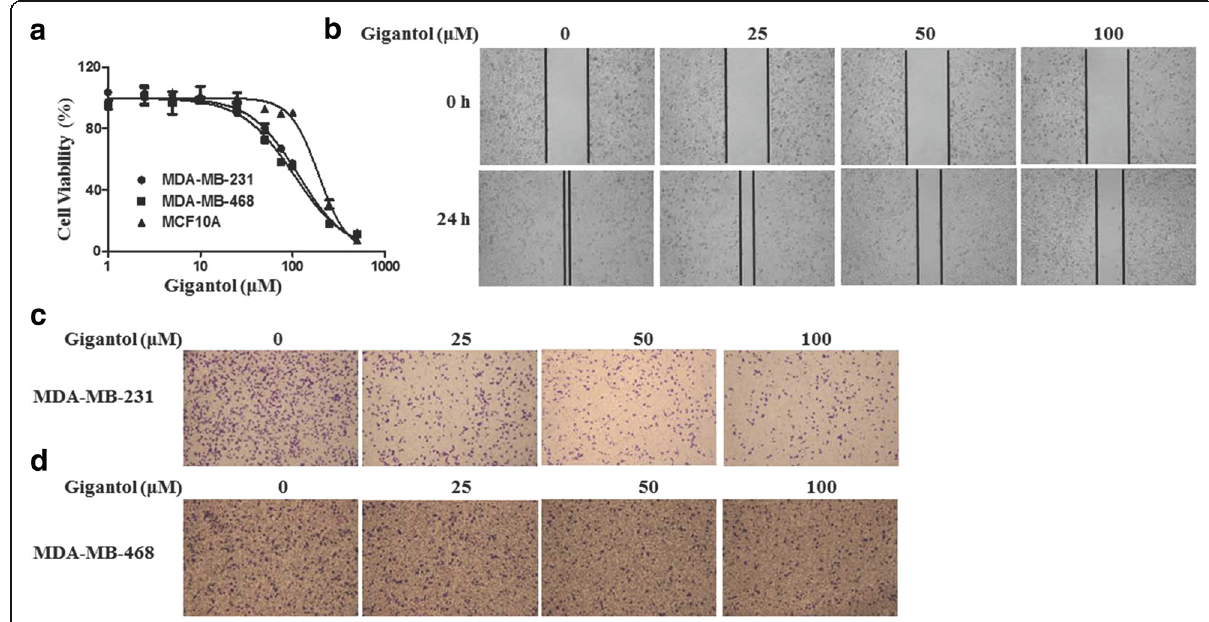
Fig. 6 Effect of gigantol on viability and migration of breast cancer cells. a MDA-MB-231, MDA-MB-468 and MCF10A cells were treated with the indicated concentrations of gigantol for 48 h, respectively. Cell viability was assessed with the MTT assay. b MDA-MB-231 cells were grown in medium contained 10% FBS. The cell monolayers were scratched and treated with varying concentrations of gigantol for 24 h and then photomicrographed. c-d MDA-MB-231 ( c ) or MDA-MB-468 ( d ) cells were treated with the indicated concentrations of gigantol for 6 h in a trans- well assay. Cells that migrated through transwells were stained with crystal violet and